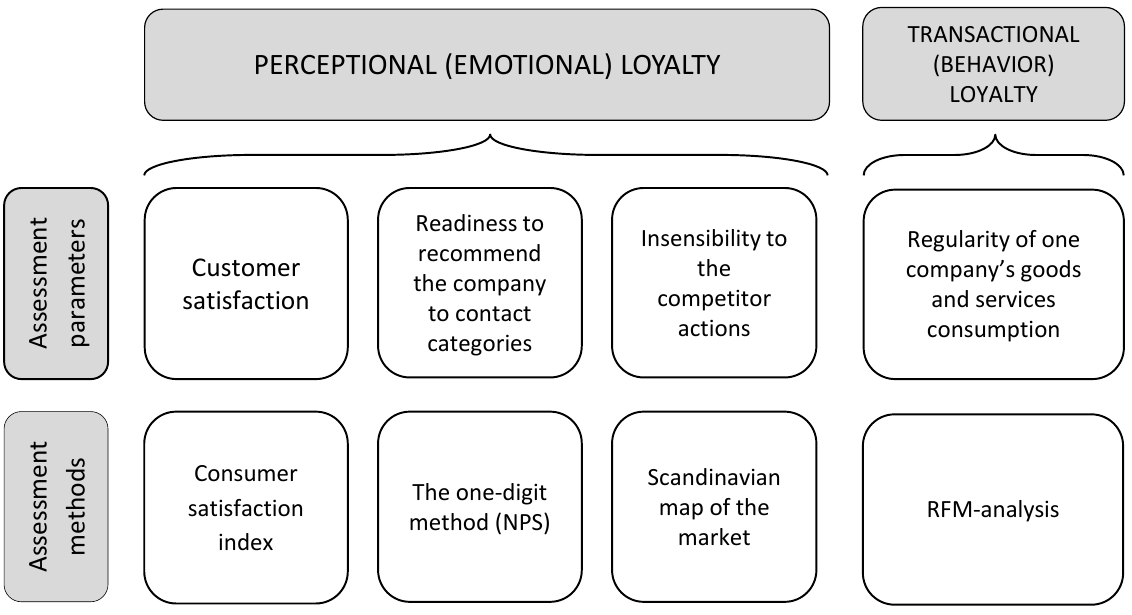
Figure 1. Parameters and methods for estimating the consumer loyalty via PSR-FM